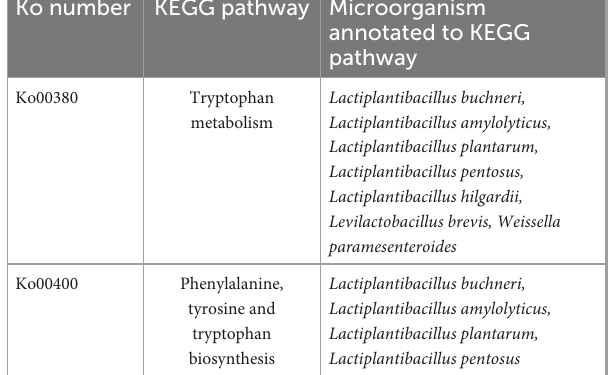
TABLE 2 KEGG metabolic pathways annotated to different microbial species. Ko number KEGG pathway Microorganism